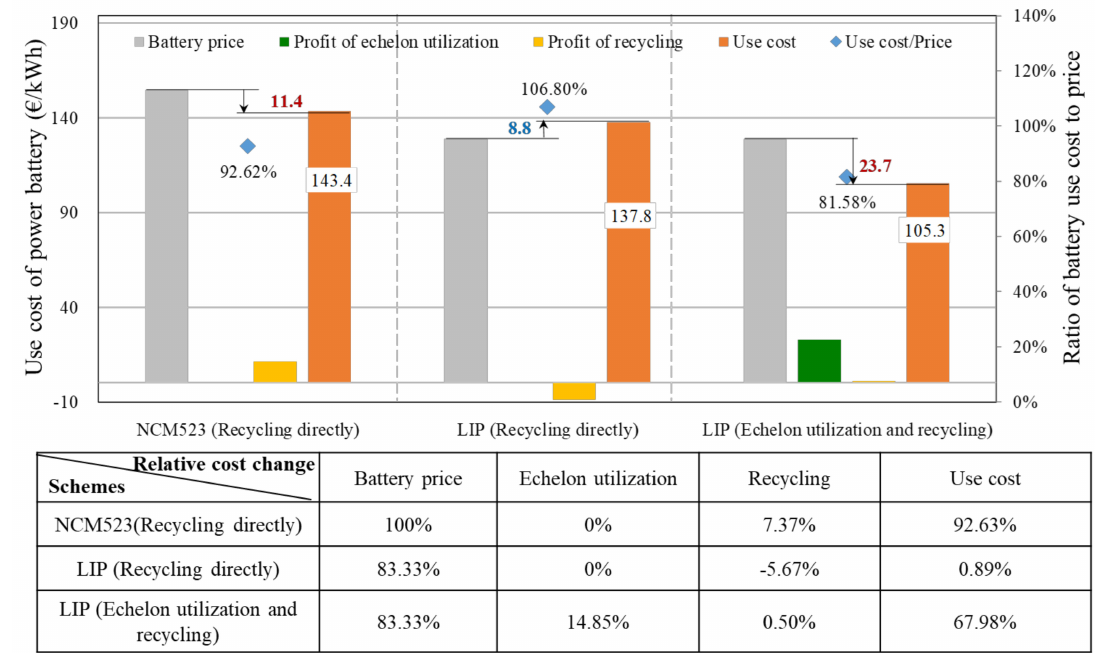
Figure 10. Comparison of use costs of NCM523 battery and LIP battery.